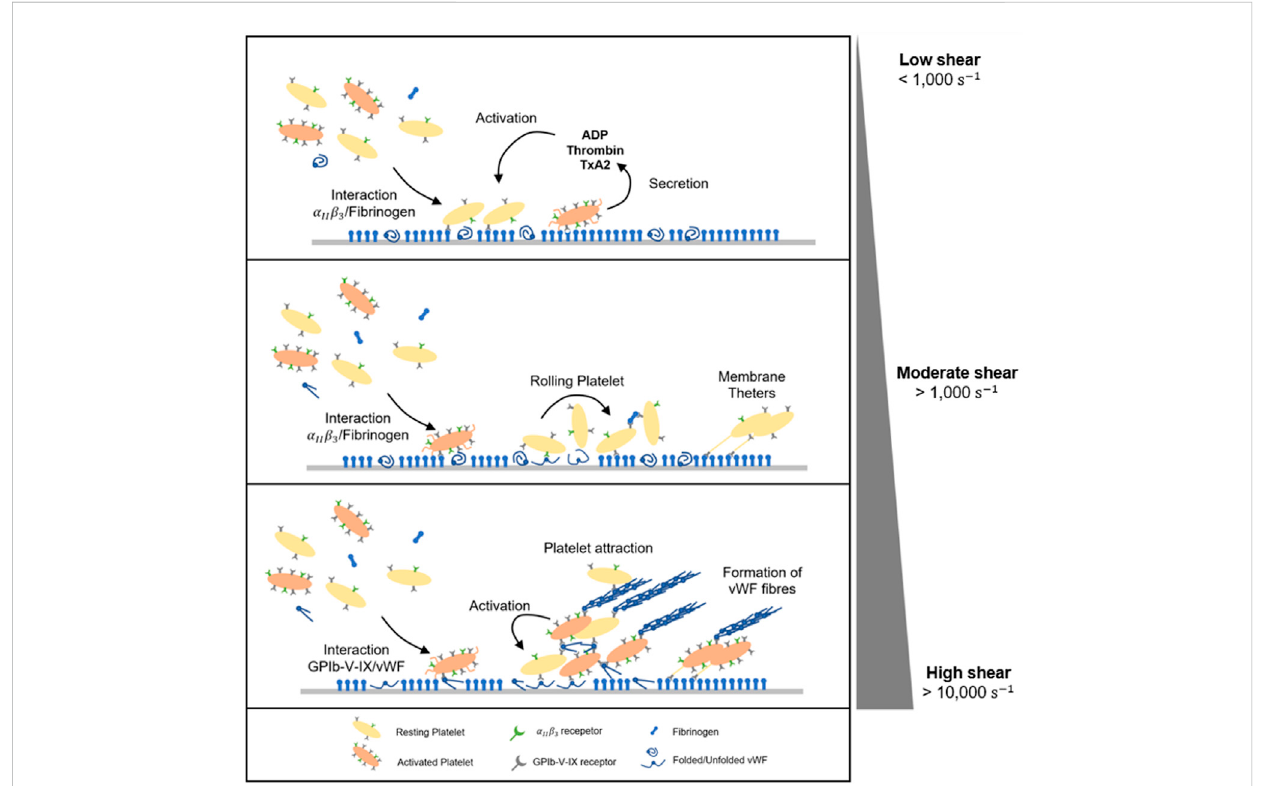
FIGURE 5 Dynamic of platelet adhesion and aggregation under fl ow. At low shear rate ( < 1,000 s -1 ), platelets adhesion and aggregation are predominantly driven by integrins α IIb β 3 receptors with fi brinogen as ligand. At moderate shear rate ( < 10,000 s -1 ), VWF fi bres adopt both folded and unfolded conformationscapturing platelets via theirreceptorGPIb-V-IX.Due tothefastdissociation